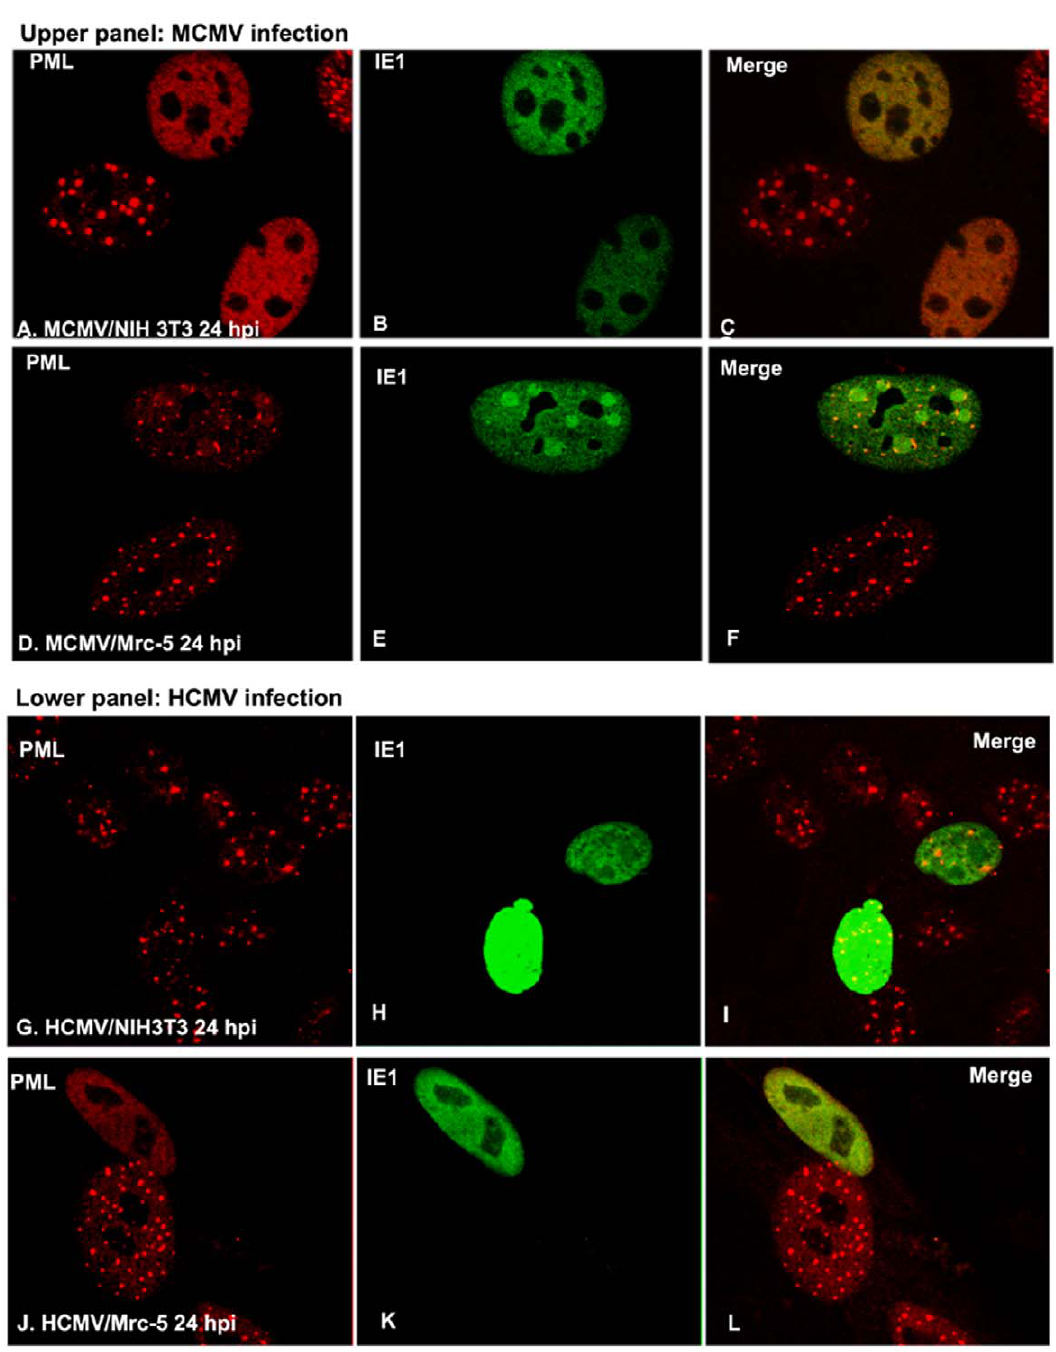
Figure 2. Immunofluorescent assay to show cytomegalovirus infection and ND10. A–C : After MCMV infection in NIH3T3 cells for 24 hours, cells were stained with anti-PML antibody (rabbit) to show ND10 (in red) (A); anti-IE1 antibody (mouse) was used to show IE1 (in green) (B); the merged picture is shown in C. D–F : After MCMV infection in Mrc-5 cells for 24 hours, cells were stained with anti-PML antibody (rabbit) to show ND10 (in red) (D); anti-IE1 antibody (mouse) was used to show IE1 (in green) (E); the merged picture is shown in F. G–H : After HCMV infection in NIH3T3 cells for 24 hours, cells were stained with anti-PML antibody (rabbit) to show ND10 (in red) (G); anti-IE1 antibody (mouse) was used to show IE1 (in green) (H); the merged picture was shown in I. J–L : After HCMV infection in Mrc-5 cells for 24 hours, cells were stained with anti-PML antibody (rabbit) to show ND10 (in red) (J); anti-IE1 antibody (mouse) was used to show IE1 (in green) (K); the merged picture is shown in L.